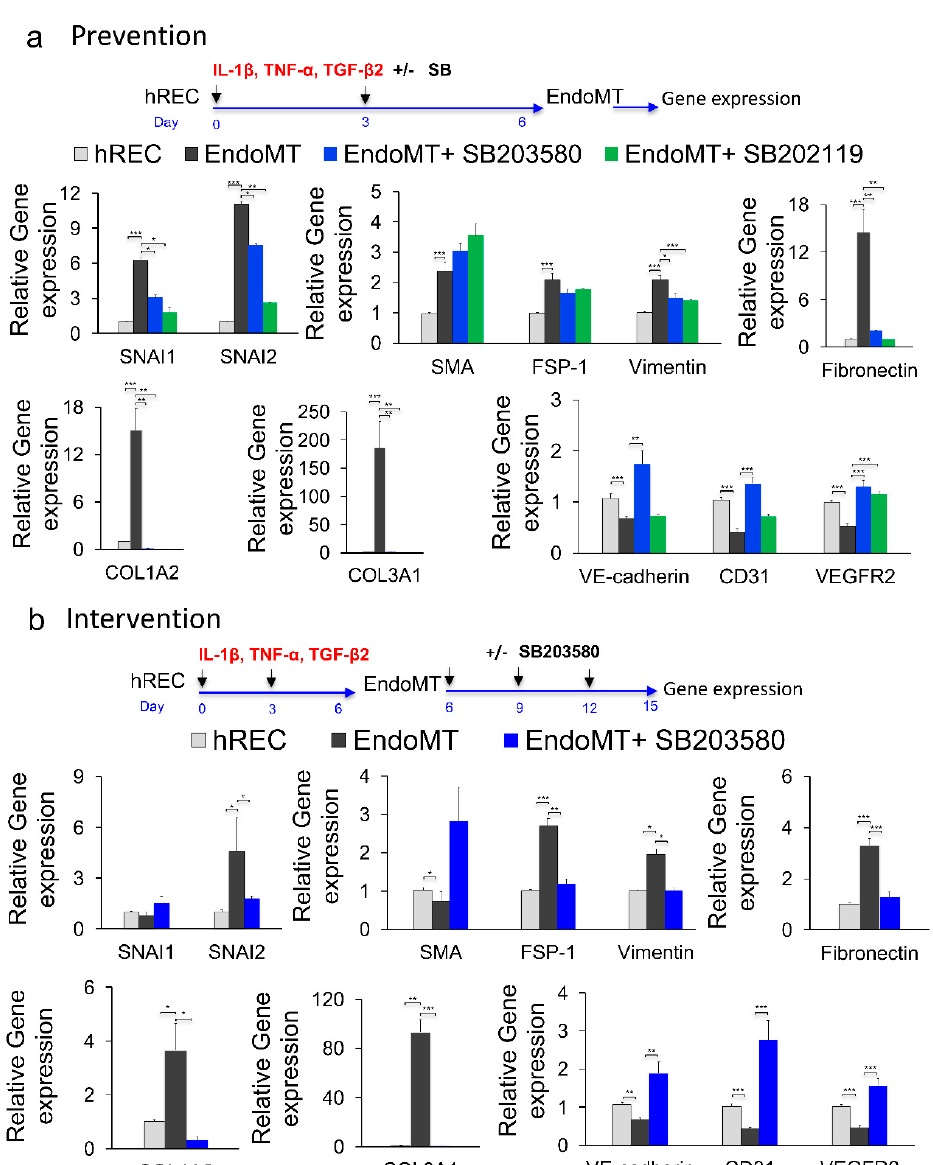
Figure 3. Phospho-p38 MAPK inhibitors prevent and reverse EndoMT-associated gene expression in vitro. ( a ) To study possible prevention of EndoMT, hREC were treated with the p38 MAPK inhibitor SB203580 or SB202190 (10 μ M) during EndoMT induction. Expression levels for the genes encoding the EndoMT-associated proteins SNAI1, SNAI2, α -SMA, FSP-1, vimentin, fibronectin, COL1A2 and COL3A1; and the endothelial differentiation markers VE-cadherin, CD31 and VEGFR2 were assessed by qPCR on day 6 of EndoMT induction. Data = mean ± SEM, * p < 0.05, ** p < 0.01, *** p < 0.001 by 2-tail unpaired t-test relative to the untreated EndoMT controls, n = 7 (COL3A1, VE-cadherin), 9 ( α -SMA, FSP-1, vimentin), 10 (SNAI1, SNAI2, fibronectin, COL1A2, CD31), 12 (VEGFR2) independent wells. ( b ) To study reversal of EndoMT, EndoMT cells were treated with SB203580 (10 μ M) for 9 days after EndoMT induction. Expression levels for the genes encoding EndoMT-associated proteins, and endothelial differentiation markers were assessed by qPCR after 9 days of treatment. Data = mean ± SEM, * p < 0.05, ** p < 0.01, *** p < 0.001 by 2-tail unpaired t-test, relative to the untreated EndoMT controls; n = 3 (COL1A2) and n = 6 (the rest of the genes) independent